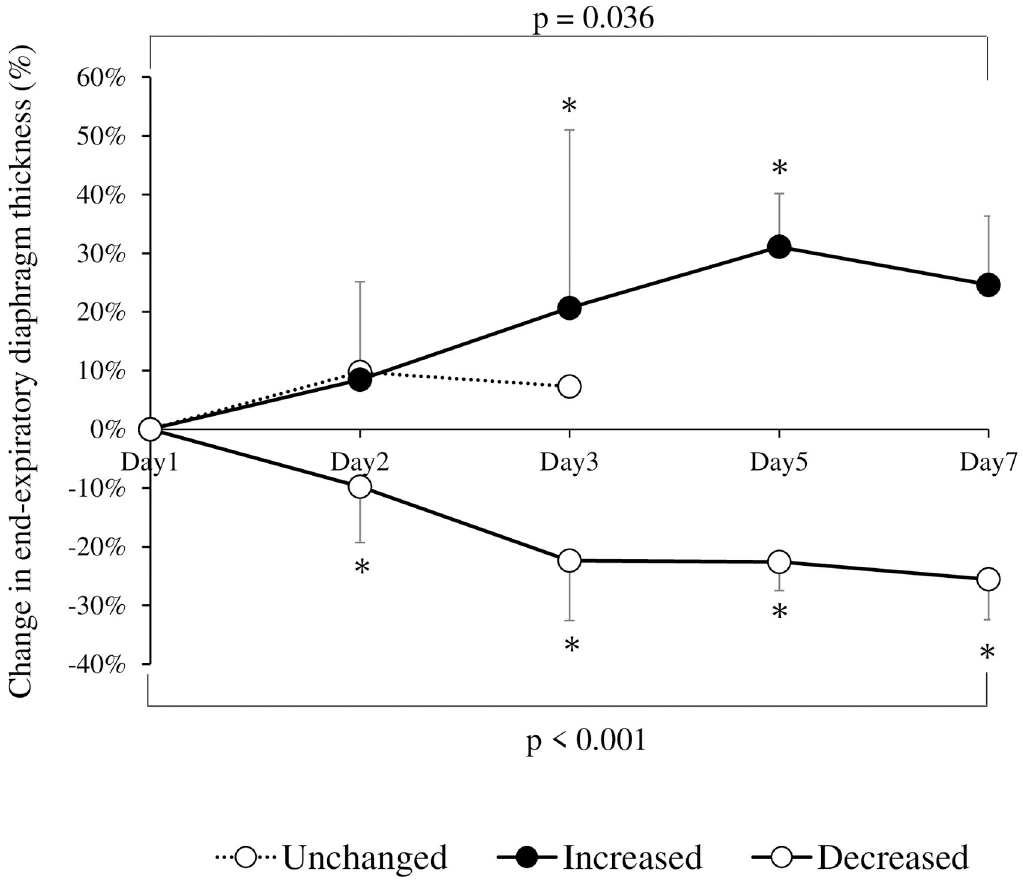
Fig 2. Changes in mean end-expiratory diaphragm thickness over time during mechanical ventilation in each group. The error bars indicate 95% confidence intervals. p values represent statistically significant differences between at least two time points (analysis of variance). � p < 0.05 versus day